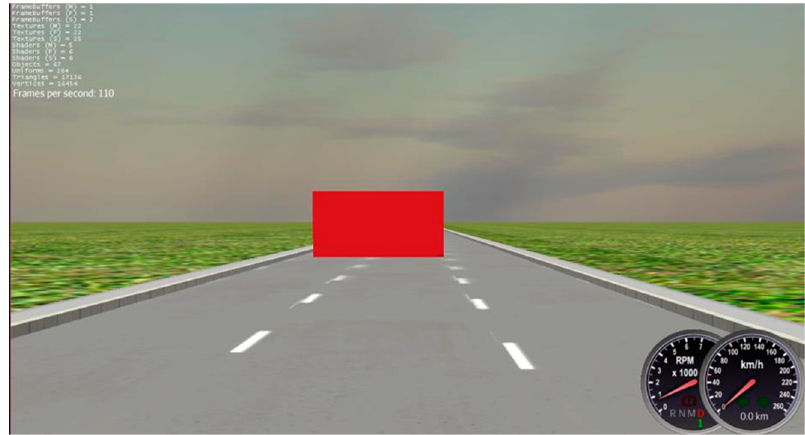
Figure 3. Demonstration of the operating system for driving reaction time (DRT) test adopted in this experiment.